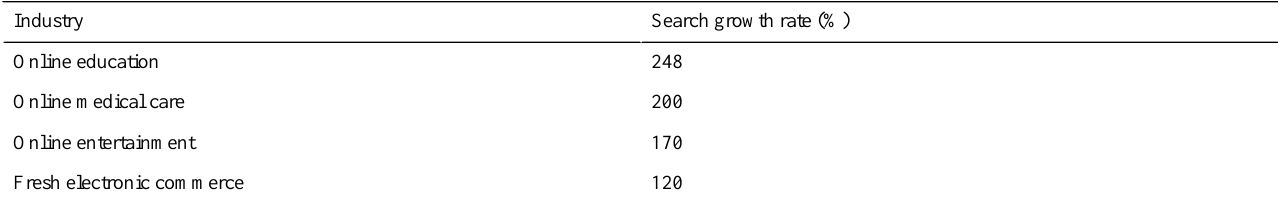
Table 1. Growth rate of search volumes of the four major industries discussed by netizens [6].